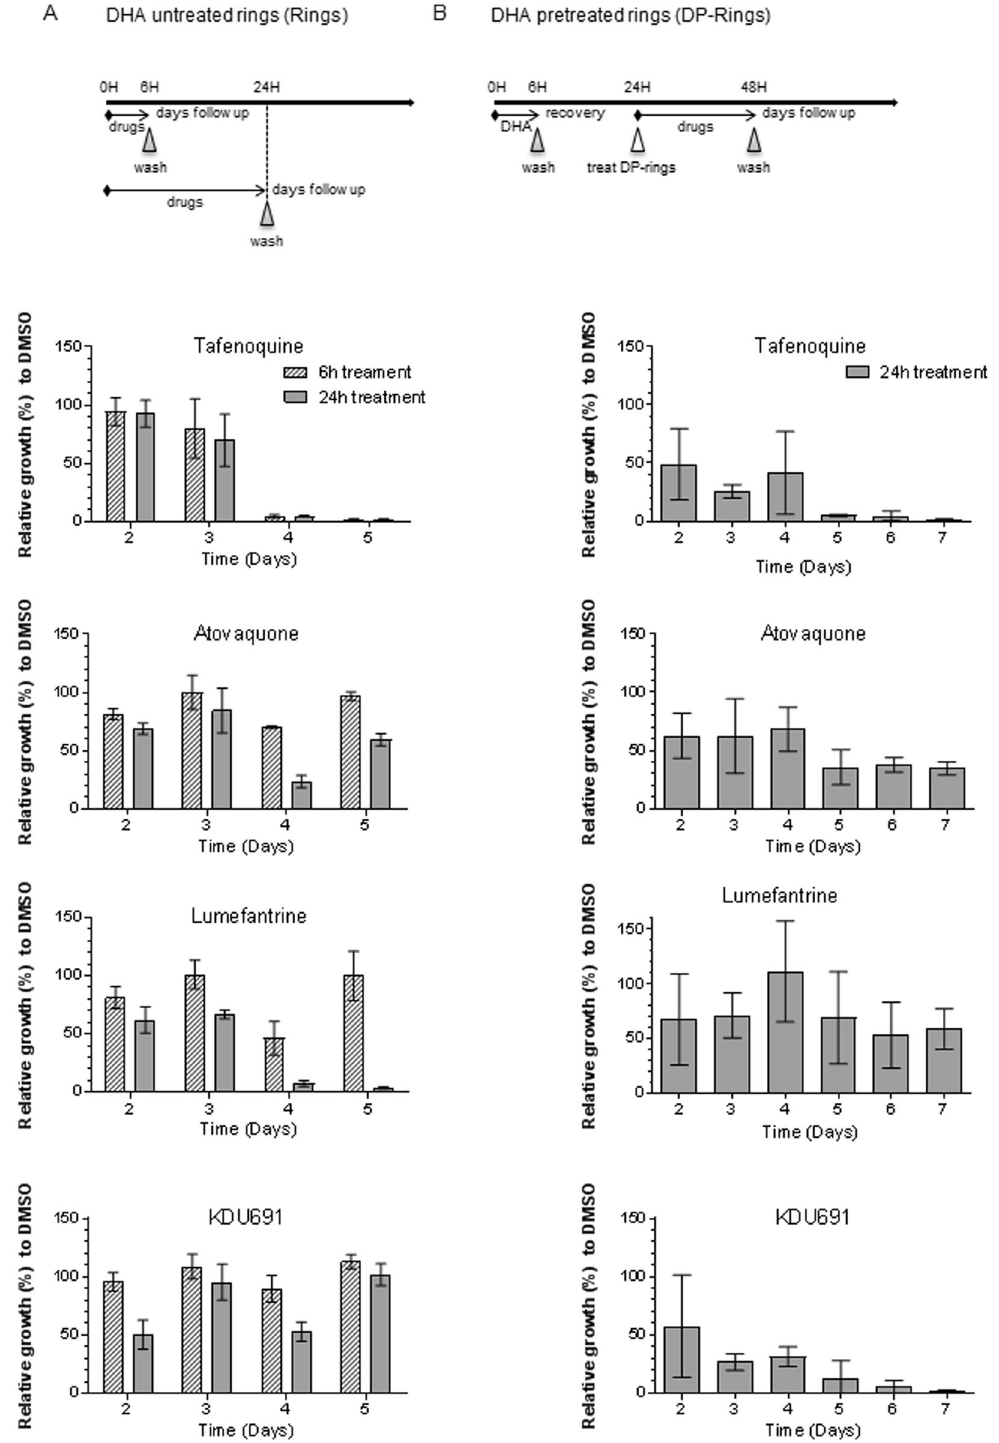
Figure 2. Selective inhibition of DP-rings appears to be specific to PI4K inhibitors. ( A ) Synchronized rings treated at concentrations corresponding to the IC 90 of TQ (0.7 µ M), ATQ (0.003 µ M), LUM (0.06 µ M), KDU691 (0.7 µ M) and untreated control for six or 24 hours. Growth was monitored by HCI. ( B ) Dormancy was induced by exposing synchronized rings to 700 nM DHA for 6 hours. After washing and a further 18 hours of culture, the DP-rings were treated with the same panel of drugs and concentrations as for panel A for 24 hours. Parasite growth was monitored for seven days by HCI. For the DP-rings, growth in the presence of drugs (applied during the period of 24 to 48 hours) was normalized to the growth of parasites not exposed to drugs during the same period. Percent growth was measured by HCI using MitoTracker ® Orange relative to DMSO. Data are from three biological experiments with technical duplicates (mean ± SEM %